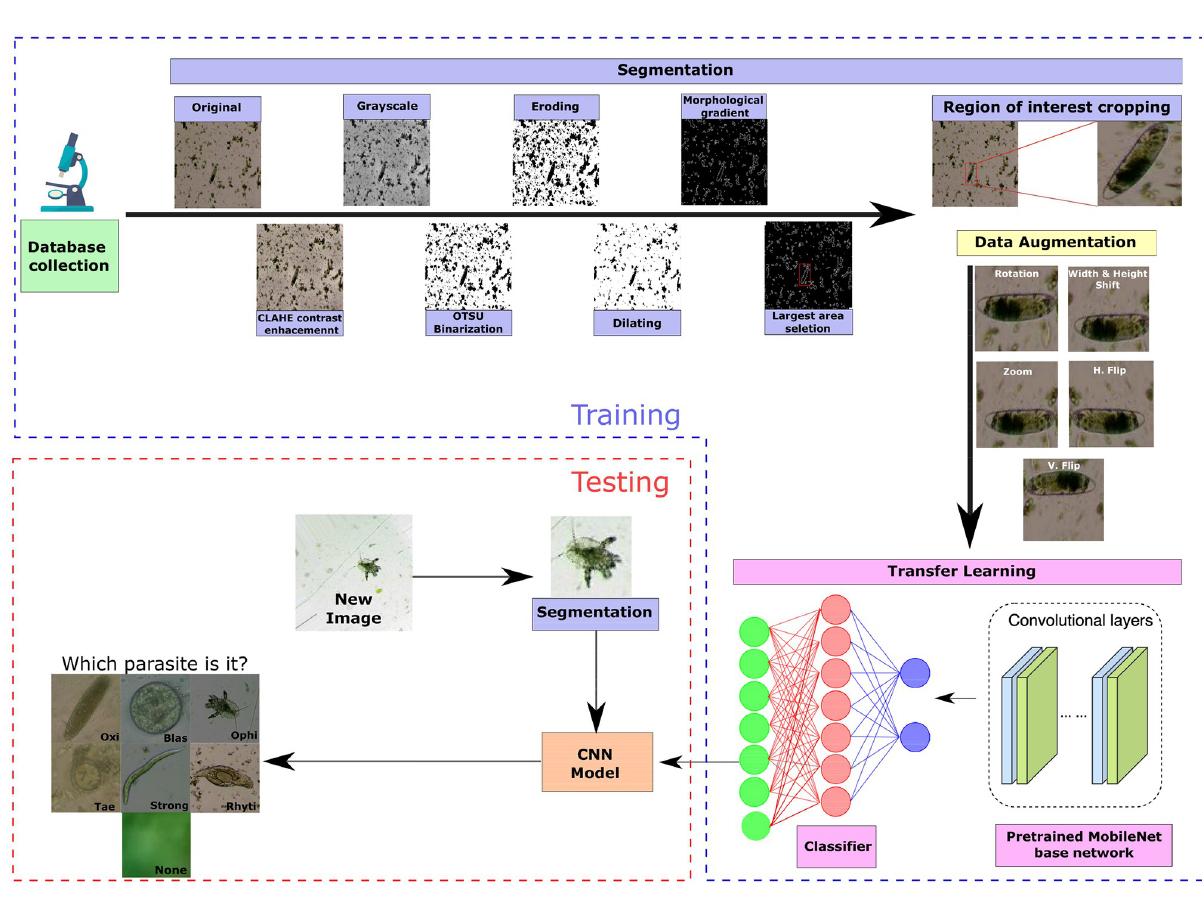
Fig 3. Block diagram of the proposed